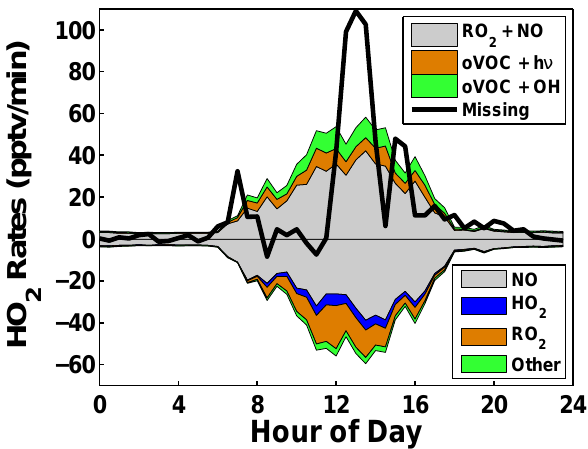
Fig. 6. Rates of HO 2 production and loss calculated from the base model scenario. Rates are grouped according to the type of reaction. Production includes reaction of RO 2 with NO (gray), VOC photol- ysis (orange) and OH oxidation of VOC (green). Losses include reactions with NO (gray), HO 2 (blue), RO 2 (orange) and OH and ozone (green). The thick black line denotes the proposed missing HO 2 source, calculated as described in the